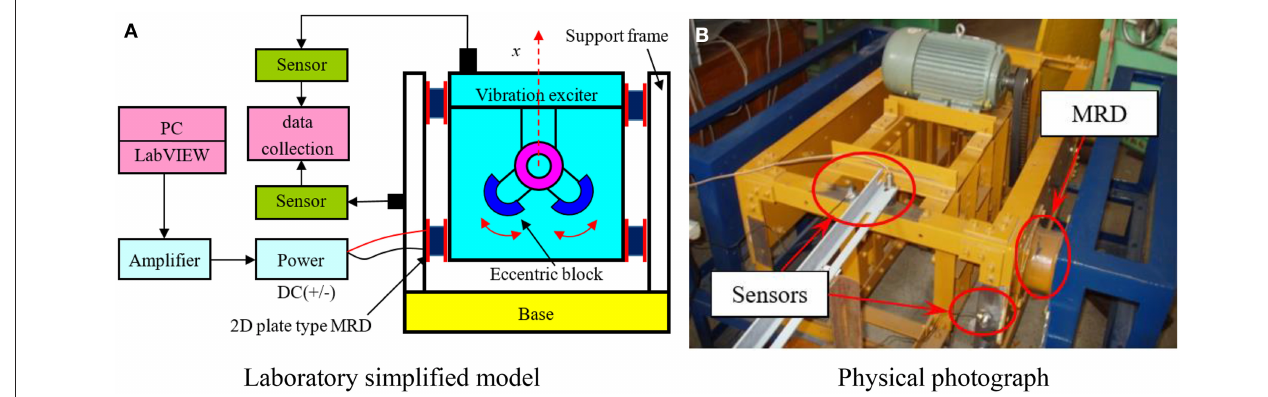
FIGURE 5 | The experimental instrument. (A) Laboratory simplified model. (B) Physical photograph.